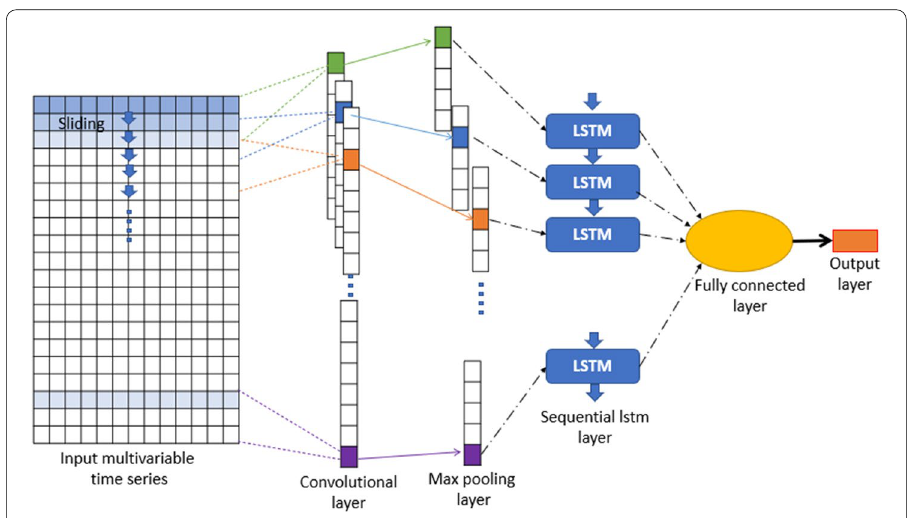
Fig. 5 Architecture of the CNN-LSTM